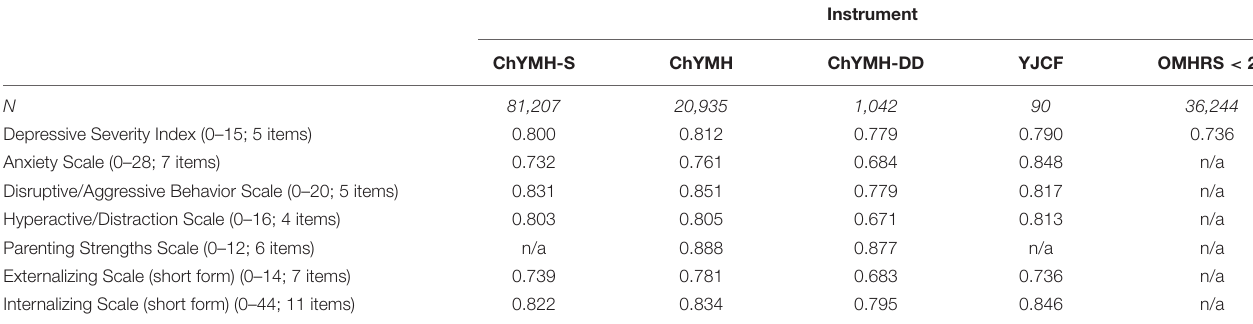
TABLE 3 | Internal consistency of clinical scales derived from interRAI child/youth mental health